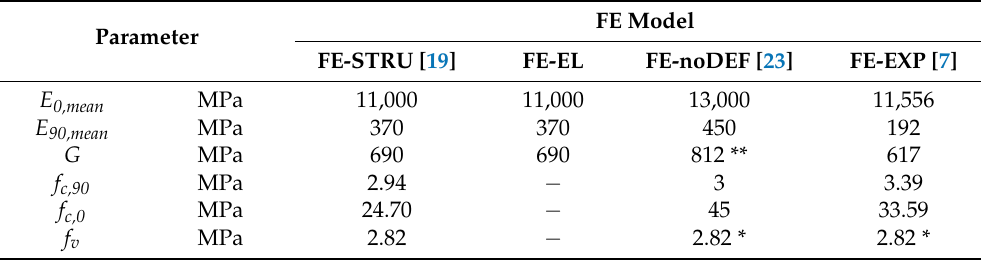
Table 1. Key input mechanical properties (mean values) for timber (ABAQUS). Key: (*) = value taken from Reference [19]; (**) = E 0,mean /16